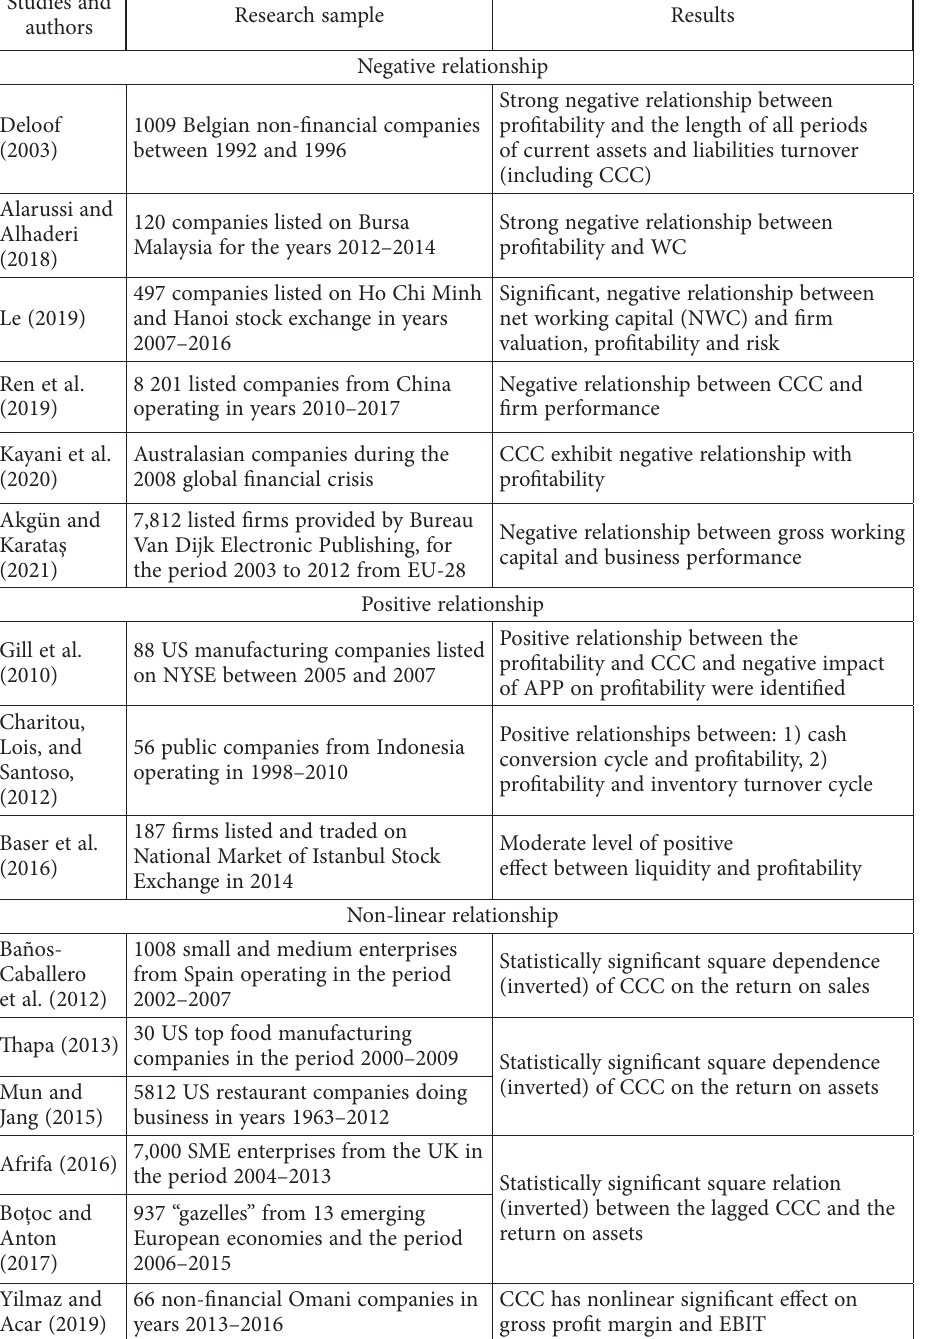
Table 1. The most important empirical studies on the relationship between profitability and WCM (source: own elaboration based on literature review) Studies and